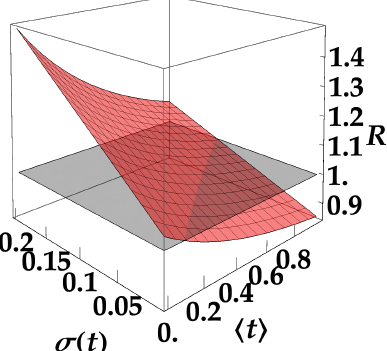
Figure 1. Theoretical expectation, according to Equation (4), of R (red surface) as a function of (cid:104) t (cid:105) and of σ ( t ) for η = 0.145, (cid:104) m (cid:105) = 2.23 and m µ = 0.04. The gray surface at R = 1 represents the boundary plane between classical and nonclassical